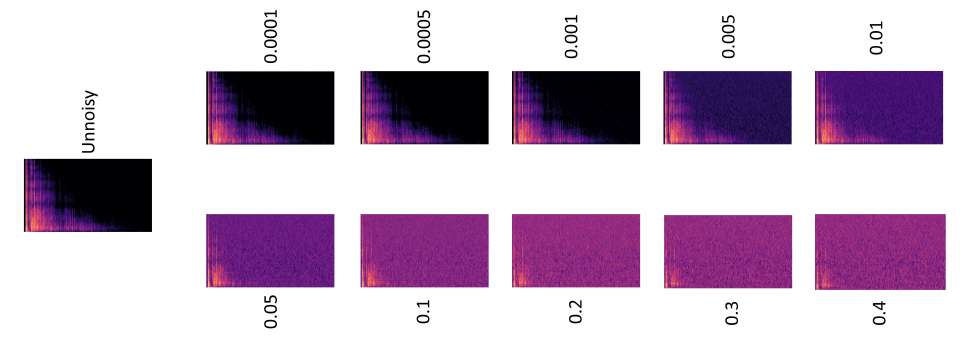
Figure 3. Spectrogram samples under unnoisy and noisy